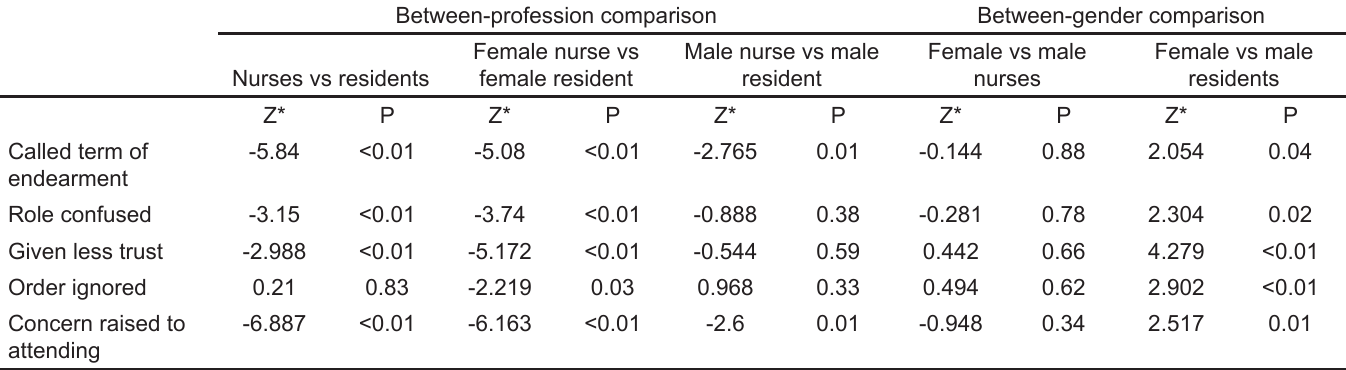
Table 4. Perceived manifestations of gender bias in interprofessional interactions.